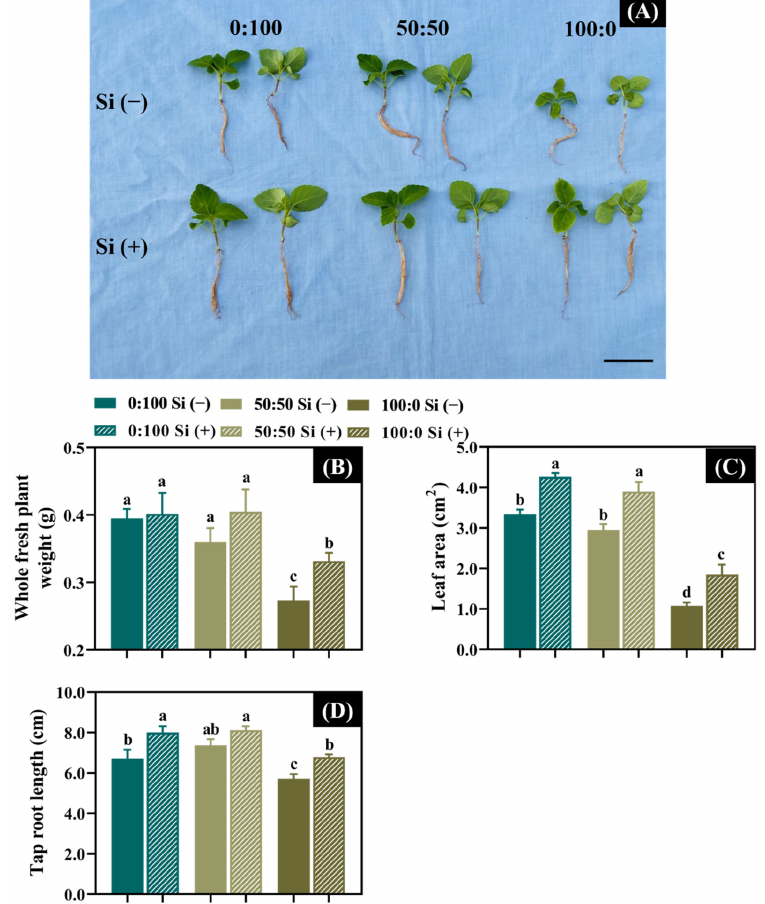
Figure 1. Effects of the three NH 4+ :NO 3 − ratios with or without Si on ( A ) salvia growth attributes in terms of the ( B ) whole fresh plant weight, ( C ) leaf area, and ( D ) tap root length. A plant pair with similar growth was employed to present the identical treatment in ( A ). Values are given as the average ± standard deviation (SD) of n = 6 replicates. Different lowercase letters (generated by Duncan’s multiple range test) were used for the statistical significances. Scale bar: 2